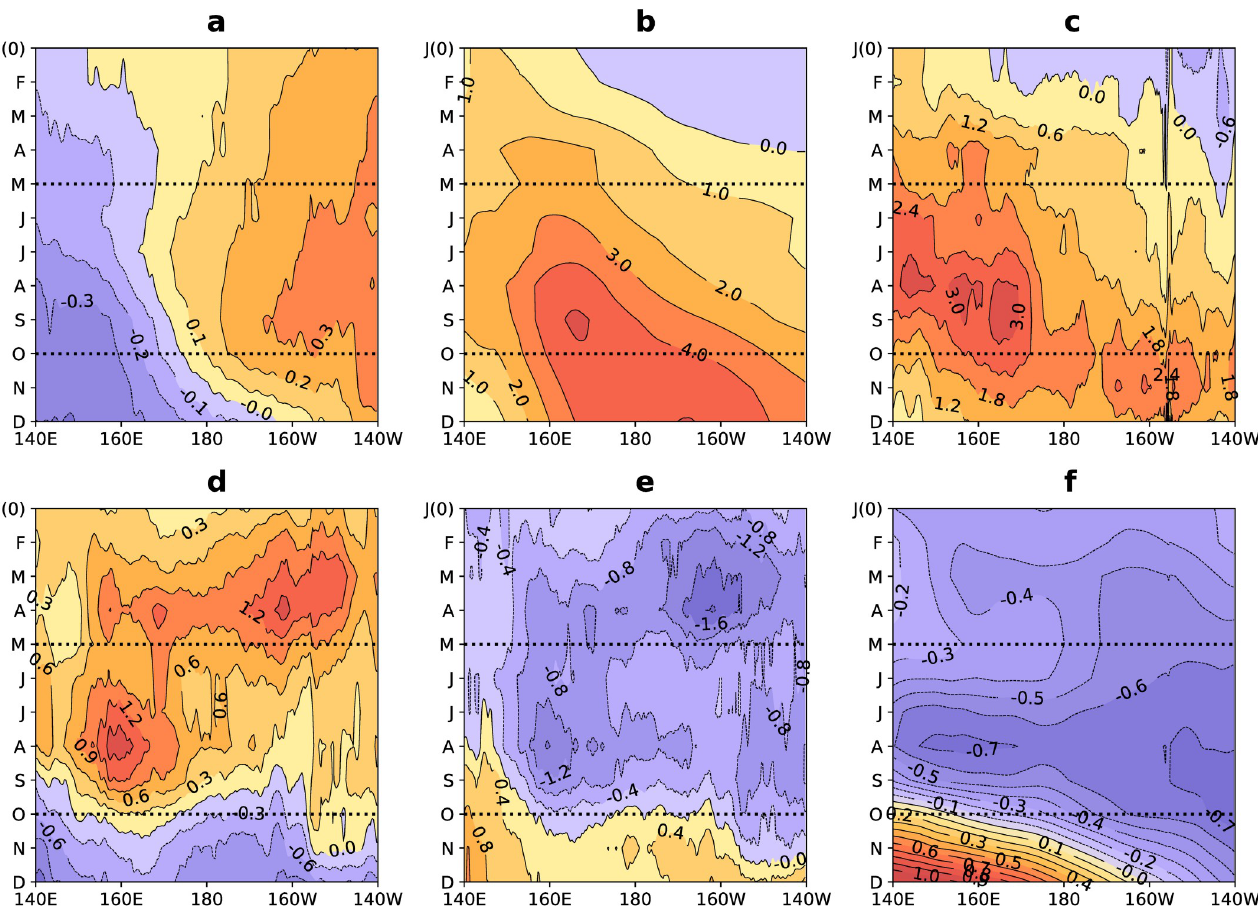
Fig 7. Composite meridional mean (5˚N–20˚N) monthly (a) sea surface temperature anomaly, (b) equatorial westerly wind anomaly, (c) relative vorticity anomaly, (d) total precipitation anomaly, (e) vertical velocity anomaly, and (f) sea level pressure anomaly during eight El Ni ñ o developing years: a, the shaded area indicates the meridional mean (5˚N–20˚N) sea surface temperature anomaly (˚C); b, same as in a, but for the equatorial westerly wind anomaly (m s -1 ) at 850-hPa; c, same as in a, but for the relative vorticity anomaly (10 − 6 s -1 ) at 850-hPa; d, same as in a, but for the total precipitation anomaly (mm); e, same as in a, but for the vertical velocity anomaly (10 − 2 Pa s -1 ) at 500-hPa; f, same as in a, but for sea level pressure anomaly (hPa). J (0)-D indicates January to December during an El Ni ñ o developing year. The black dotted lines represent May to October.